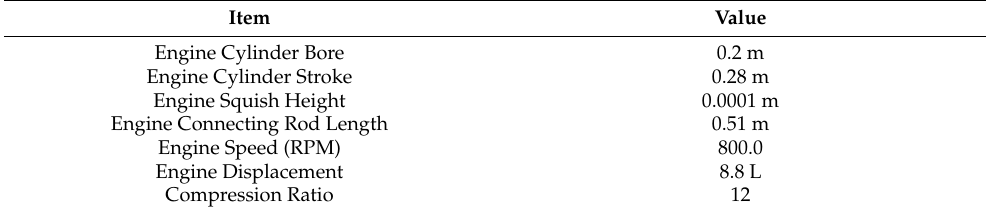
Table 1. The test engine